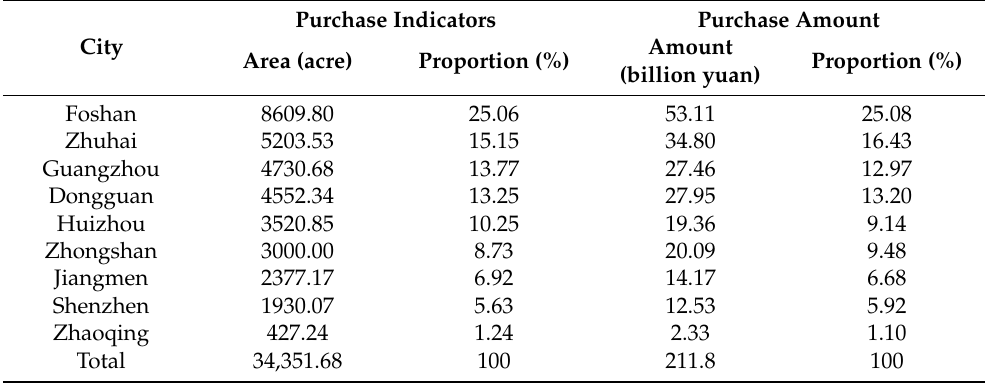
Table 6. Area for sale and purchase of demolition and reclamation targets for prefecture-level administrative